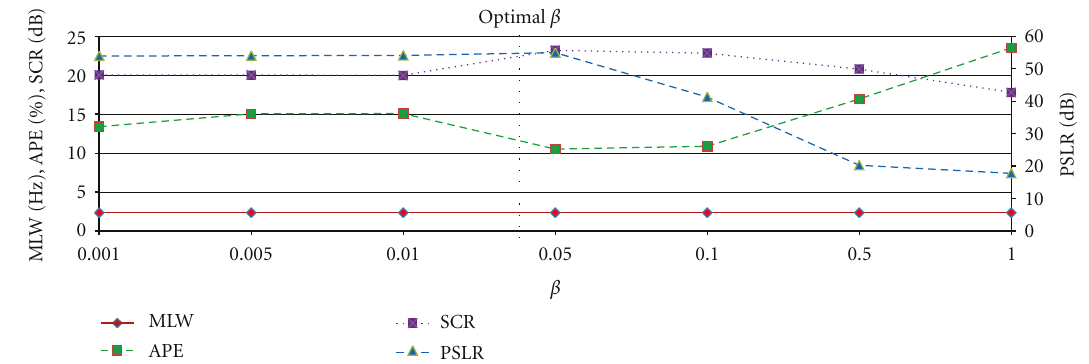
Figure 6: Performance comparison of the TFR using BD with various β for harmonic signal.